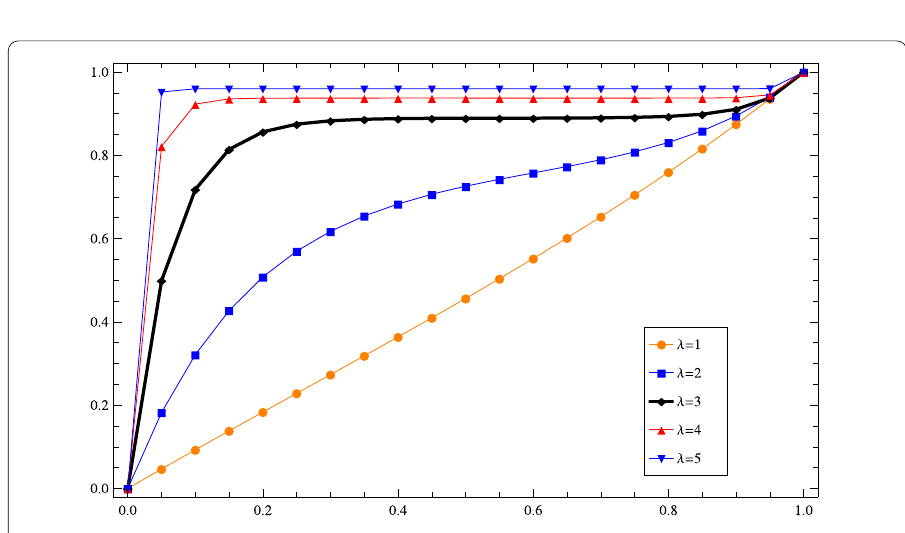
Figure 12 Plot of numerical solutions of approach I for ν 0 = 1, λ = 1, ... ,5, and n = 1